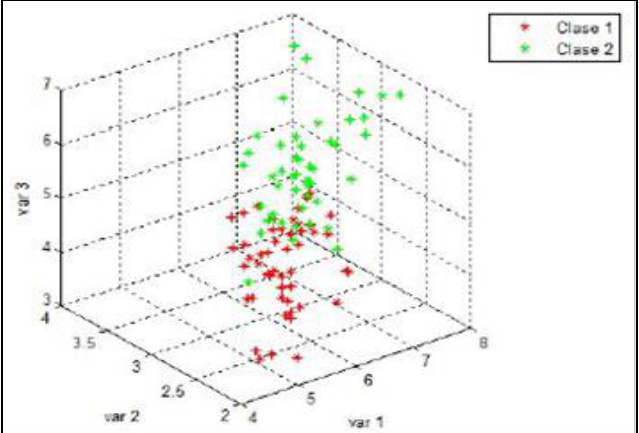
Figura 4: Clases mezcladas. Fuente: Los Autores,